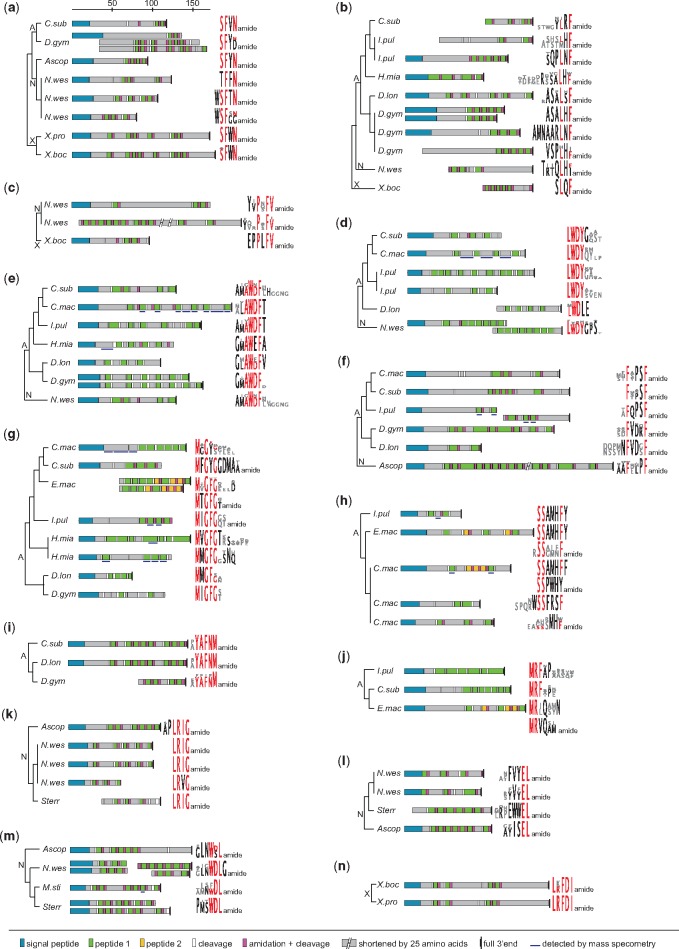
Neuropeptide precursors and their peptide sequence logo representations of xenacoelomorph-specific MCPs. (a) SFxNamides. (b) LxFamides. (c) PxFVamides. (d) LWDY peptides. (e) AWDF peptides. (f) FxxxFamides. (g) MxGFG peptides. (h) SSxxxF peptides. (i) YAFNMamides. (j) MRF peptides. (k) LRIGamides. (l) ELamides. (m) WDLamides. (n) LRFDIamides. Peptide sequence logo representations are created using all aligned peptide sequences of the corresponding precursor. Conserved amino acid residues between species are highlighted in red. A, Acoela; N, Nemertodermatida; X, Xenoturbella; Ascop, Ascoparia sp.; C.sub, Childia submaculatum; C.mac, Convolutriloba macropyga; D.gym, Diopisthoporus gymnopharyngeus; D.lon, Diopisthoporus longitubus; E.mac, Eumecynostomum macrobursalium; H.mia, Hofstenia miamia; I.pul, Isodiametra pulchra; M.sti, Meara stichopi; N.wes, Nemertoderma westbladi; Sterr, Sterreria sp.; X.boc, Xenoturbella bocki; X.pro, Xenoturbella profunda.